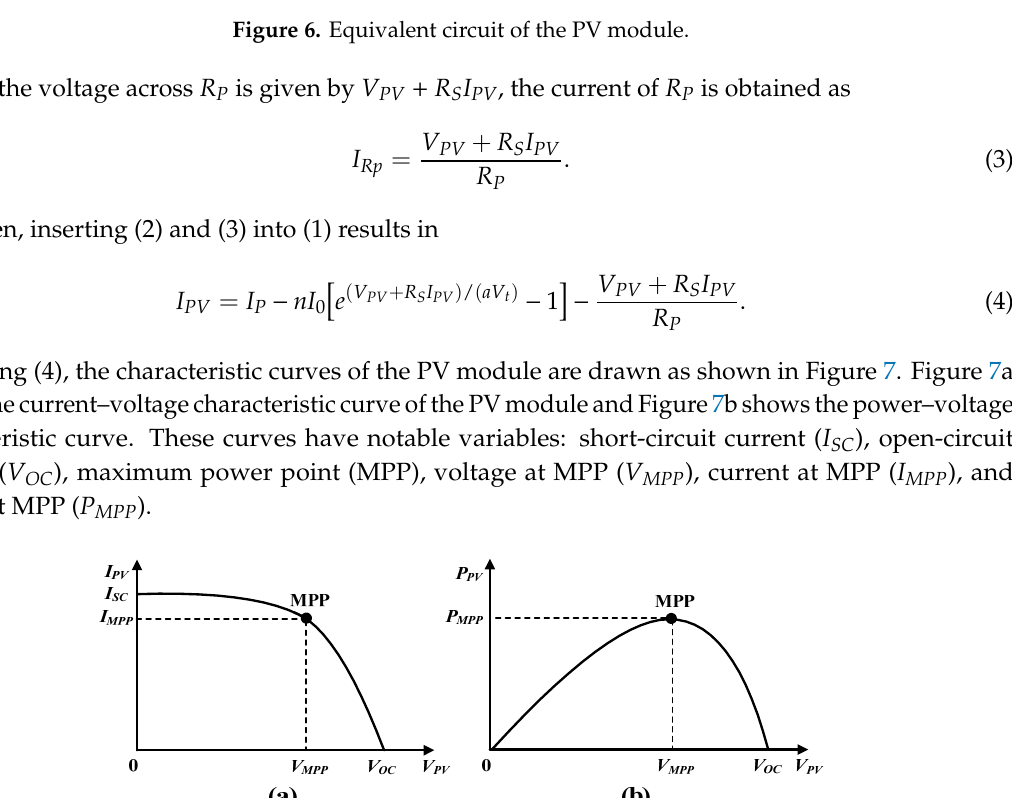
Figure 7. ( a ) Current–voltage characteristic curve and ( b ) power–voltage characteristic curve of the PV module.